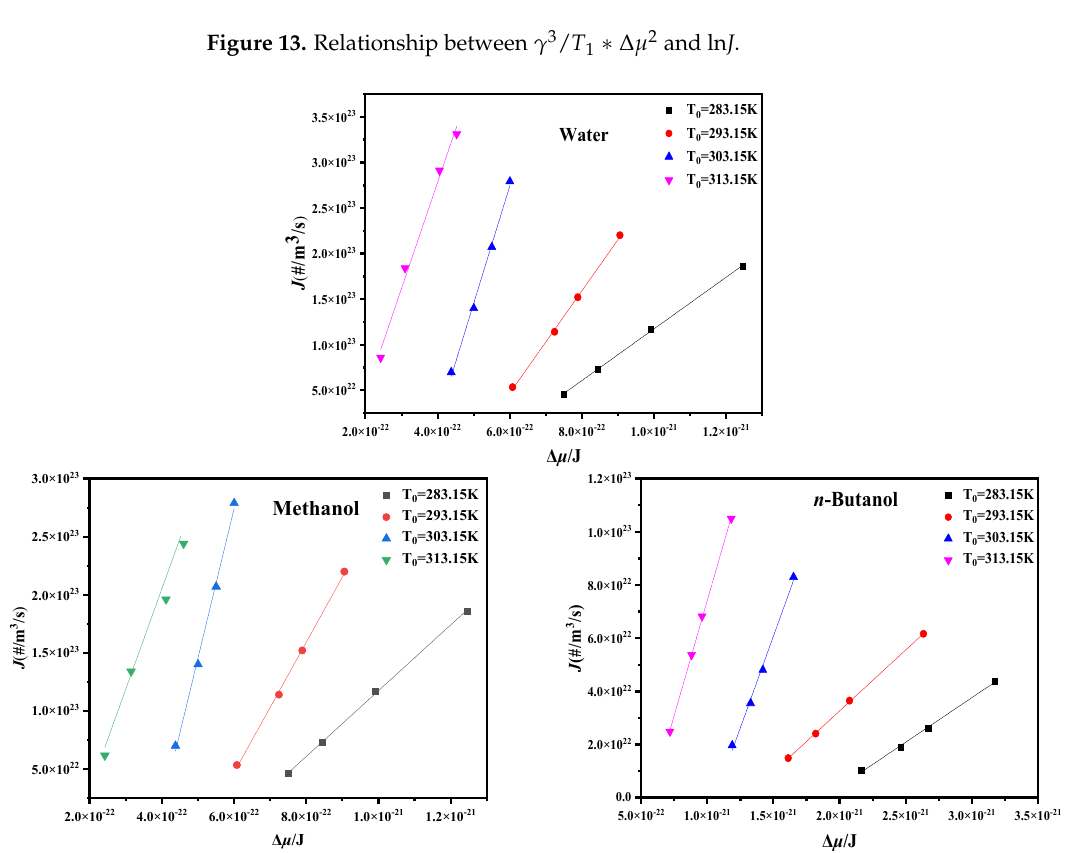
Figure 13. Relationship between γ 3 /T 1 * Δ μ 2 and ln J.